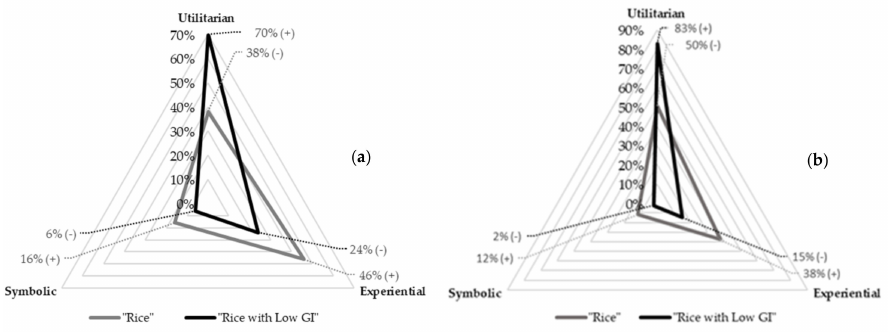
Figure 4. Frequency of ( a ) respondents and ( b ) words associated with each consumption values (utilitarian, experiential, symbolic) and stimuli (“rice” and “rice with low GI”). Effect of the chi-square per cell: (+) or ( − ) indicate that the observed value is significantly ( p < 0.001 for all comparisons) higher or lower than the expected theoretical